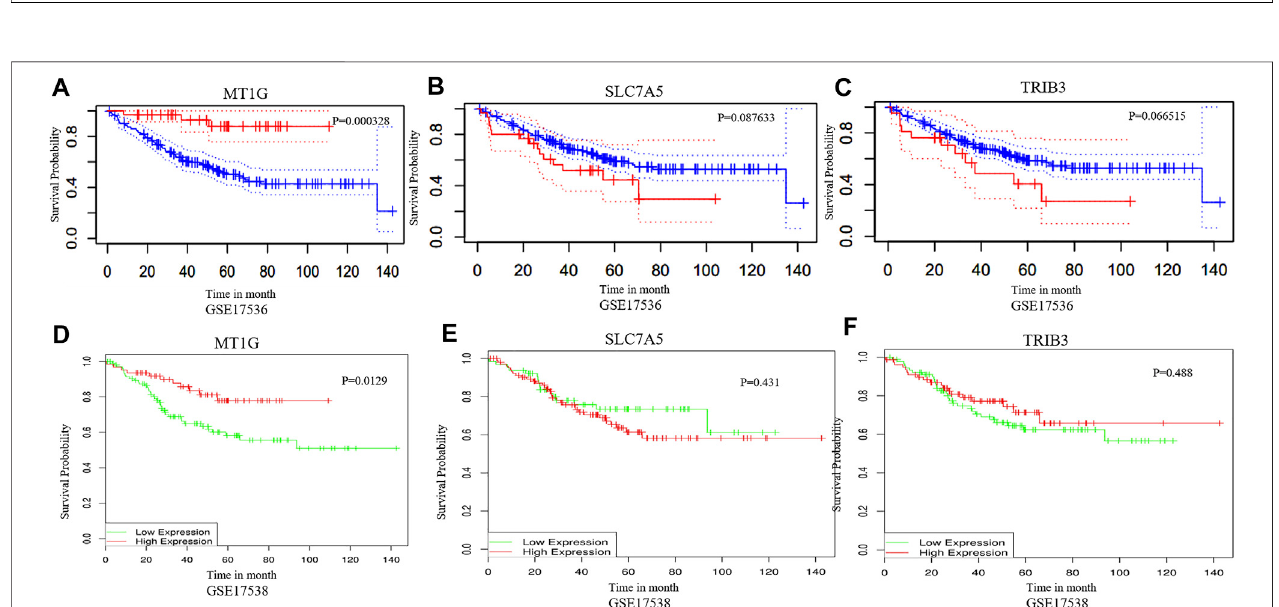
FIGURE 2 | Prognostic value analysis of MT1G, SLC7A5, and TRIB3 in CRC. (A – F) PrognoScan database and DRUGSURV database indicated the prognostic values of MT1G, SLC7A5, and TRIB3 in CRC patients.